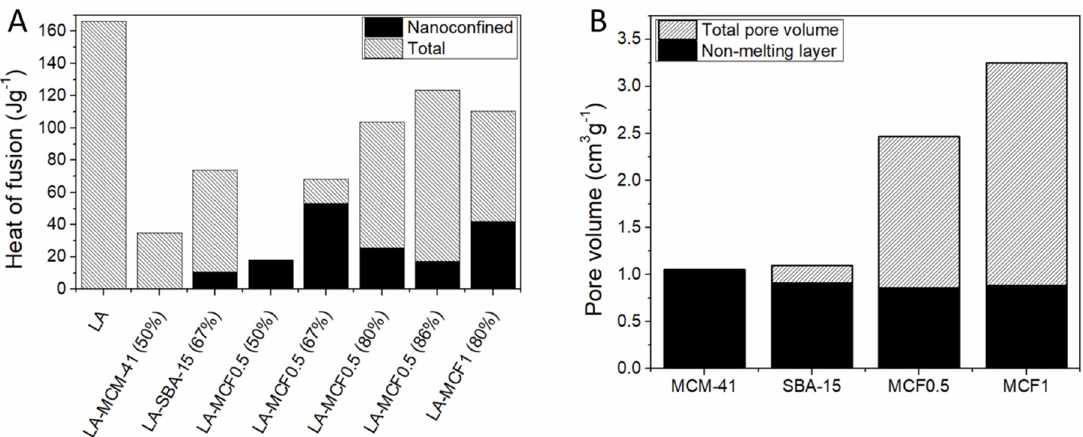
Figure 10. ( A ) Heat of fusion corresponding to the nanoconfined phase and total enthalpy and ( B ) non-melting layer specific volume as a fraction of total pore volume for four types of MSN matrices. Data from ref. [67].